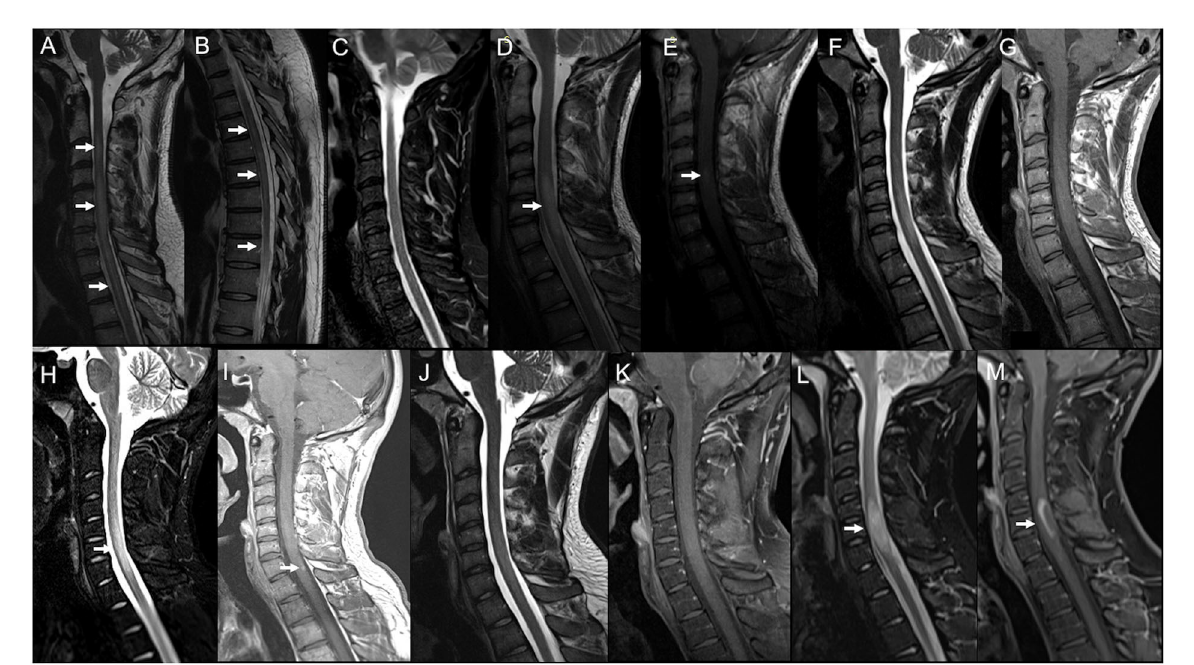
FIGURE1 Serial spinal cord MRI scans in Case 1 (A–C) and Case 2 (D–M) . Case 1: Cervical (A) and thoracic (B) spinal cord MRI obtained 10 days after Ad26.COV2.S first dose showed a T2-weighted hyperintensity irregularly extending from C3 to medullaris conus with swelling from C4 to C7 (arrows) and no gadolinium enhancement (not shown). (C) 8-months MRI follow-up showing the complete resolution of the swelling and marked amelioration of the signal abnormality, barely visible on Short Tau Inversion Recovery (STIR) images. Case 2: (D) Spinal cord MRI performed 3 months after Tdap and IVP vaccine administration, showing a T2-weighted hyperintensity from C5 to C7 (arrow) with swelling and blurred contrast-enhancement on T1-weighted sequence (E) (arrow). (F) 6-months MRI control showing the cervical lesion shrinkage on T2-weighted sequences and no more contrast-enhancement (G) . (H) Spinal cord MRI obtained 8 days after the BNT162b2 second dose, showing swelling on STIR (arrow) and gadolinium enhancement [ (I) ; arrow] of the previously detected lesion. (J) 4-months MRI showed showing marked reduction of the signal abnormality and no more enhancement on the T1-weighted image (K) . (L) Spinal cord MRI obtained 62 days after the BNT162b2 third dose, showing a new swelling (arrow) and gadolinium ring enhancement (M) of the known cervical